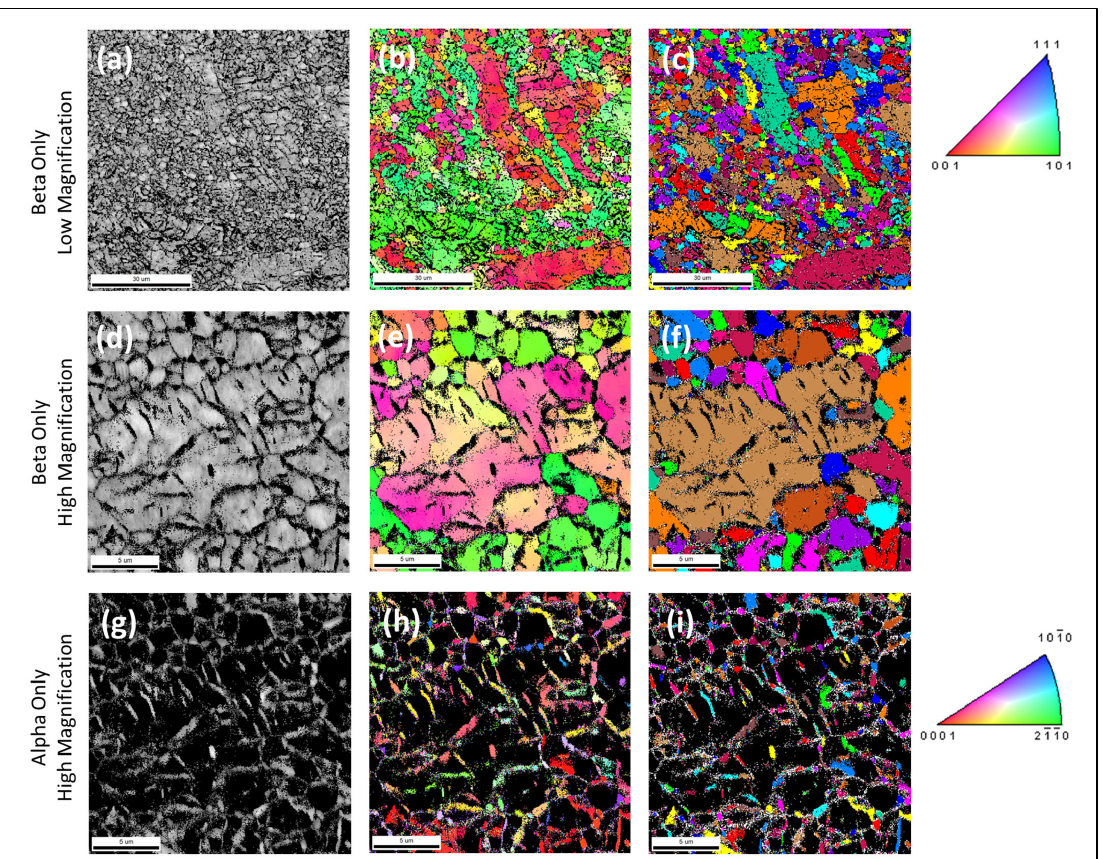
Figure 18 . Electron backscatter diffraction (EBSD) band contrast maps, phase maps, and orientation maps of beta low magnification ( a – c ), beta high magnification ( d – f ), and alpha high magnification ( g – i ).